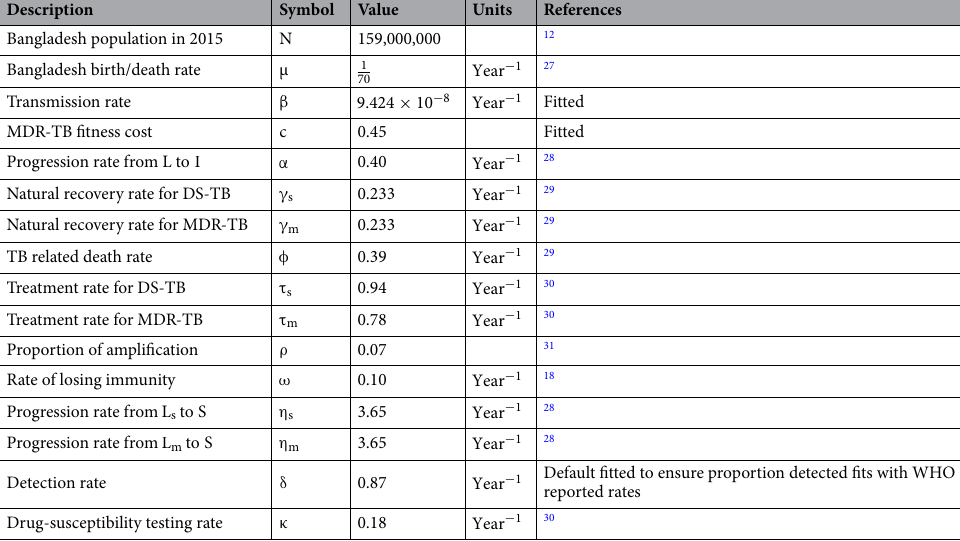
Table 1. List of parameters, symbols, plausible values, units and references.